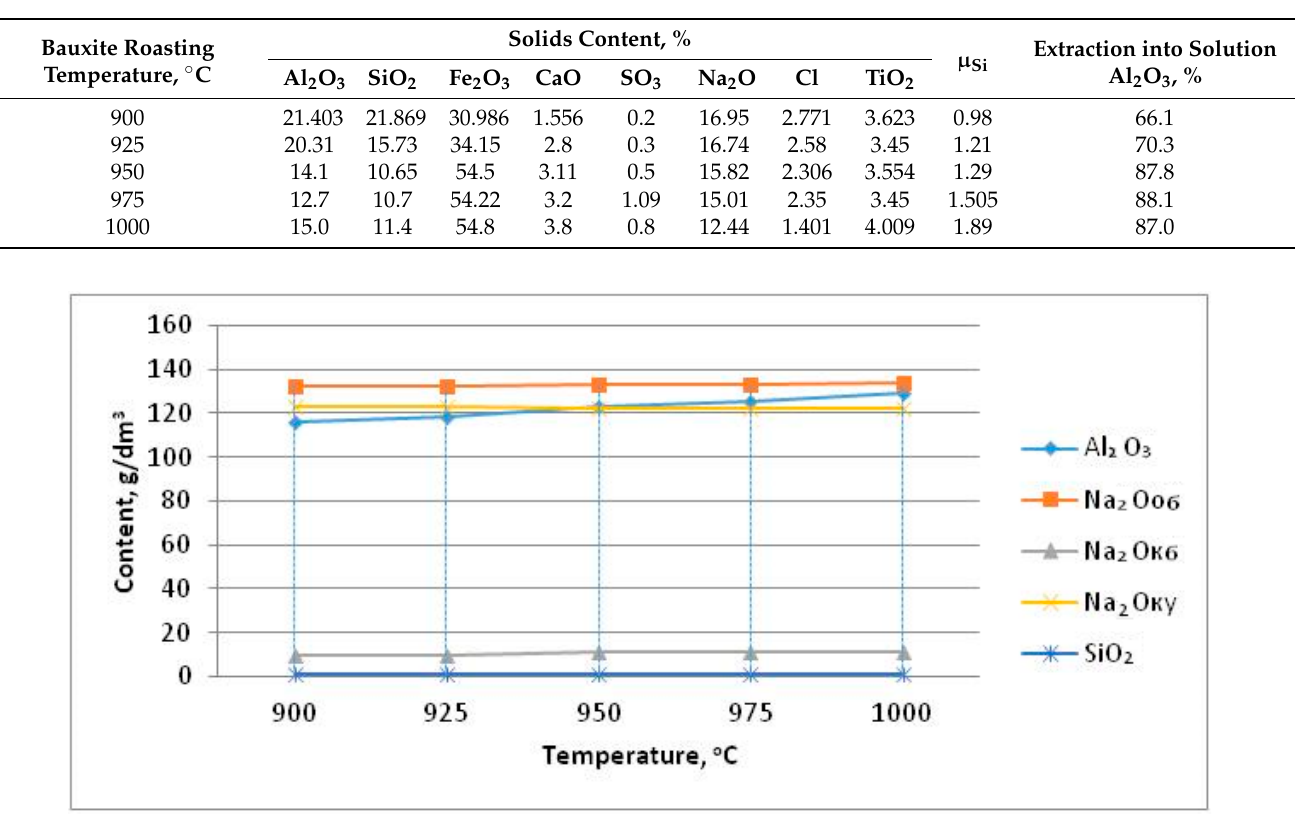
Table 2. The compositions of aluminate solutions (with α к y and μ Si ).